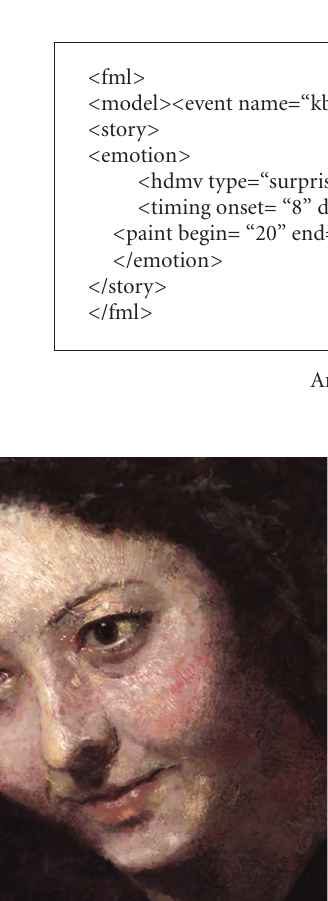
Figure 2: Sample output rendered by the Painterly system using a source image and a painterly configuration